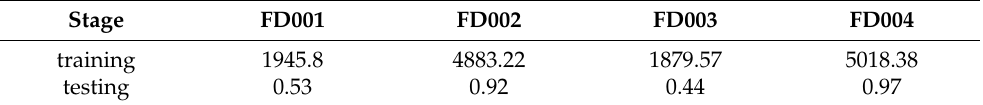
Table 3. The training and testing time (in seconds) of the proposed